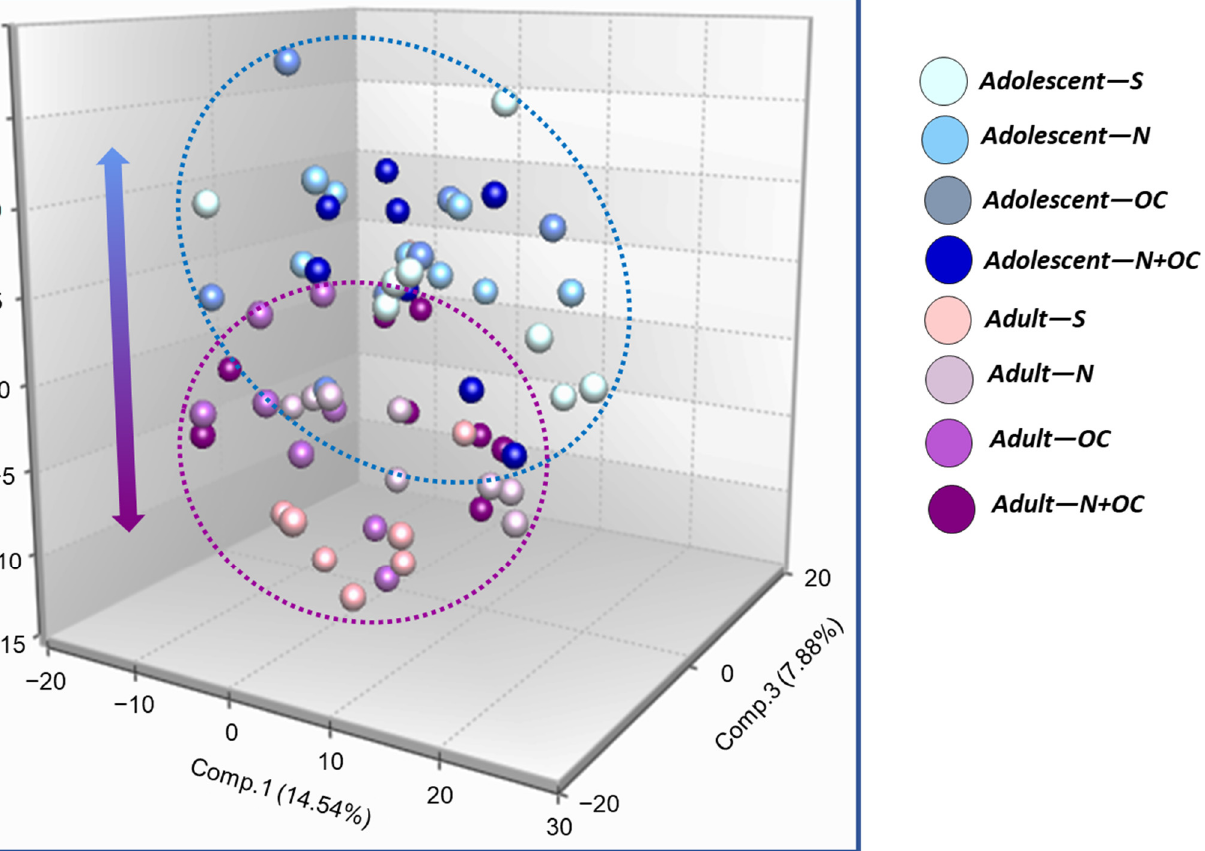
Figure 1. PCA analysis shows clustering of cortical samples from female rats exposed to N, OC, or N + OC cluster by age (adolescent vs. adult), with modest separation of samples by experimental treatment (saline vs. N, OC, or N + OC) in the adolescent group, which is suggestive of age-dependent metabolic changes.